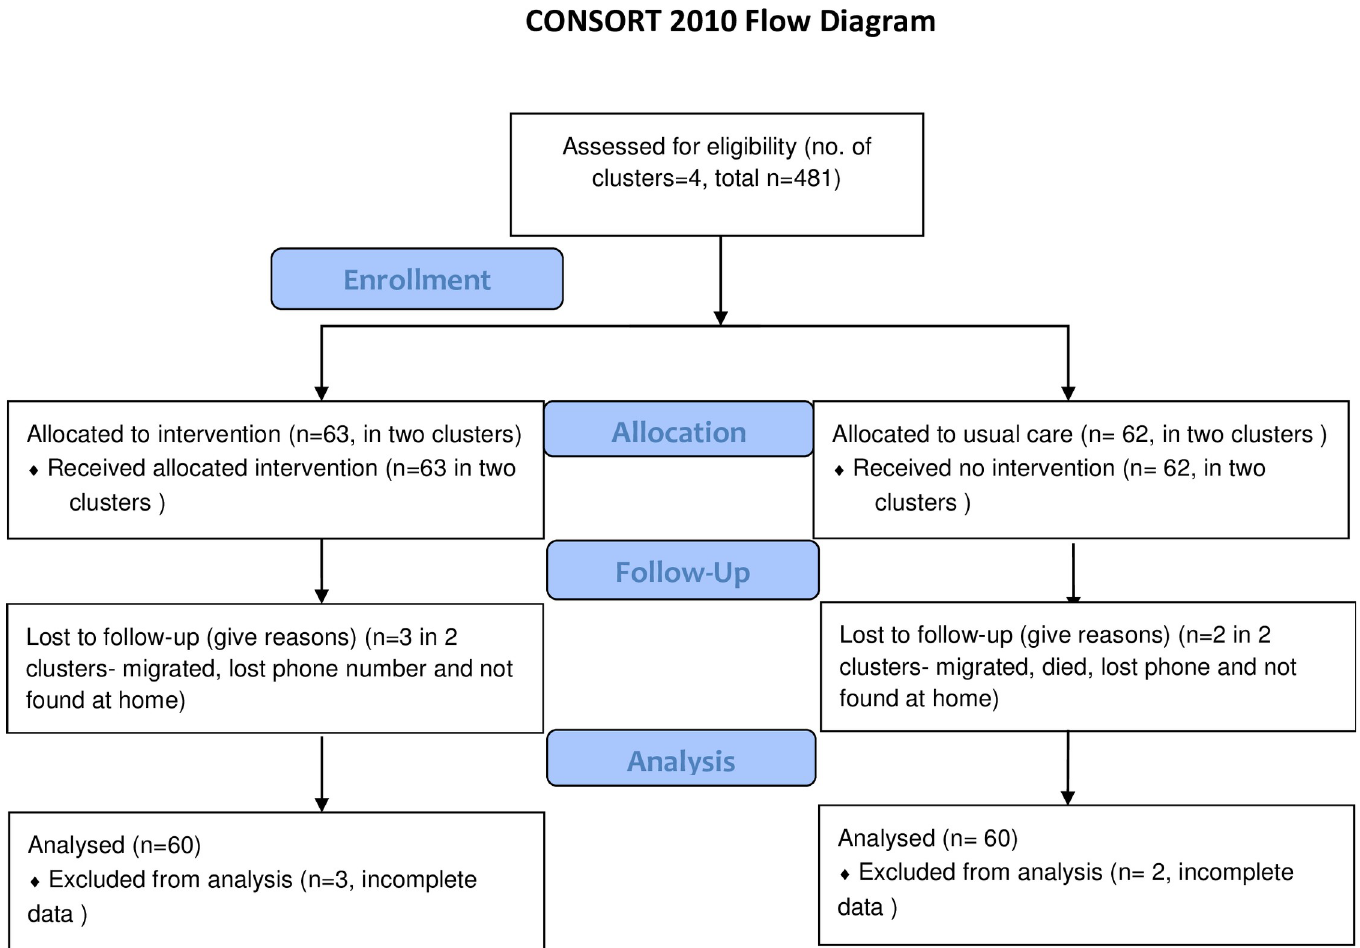
Fig 1. CONSORT 2010 flow diagram of study